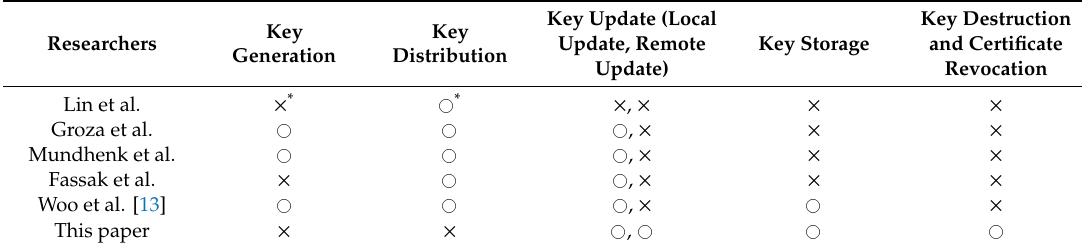
Table 1. Main research topics from di ff erent